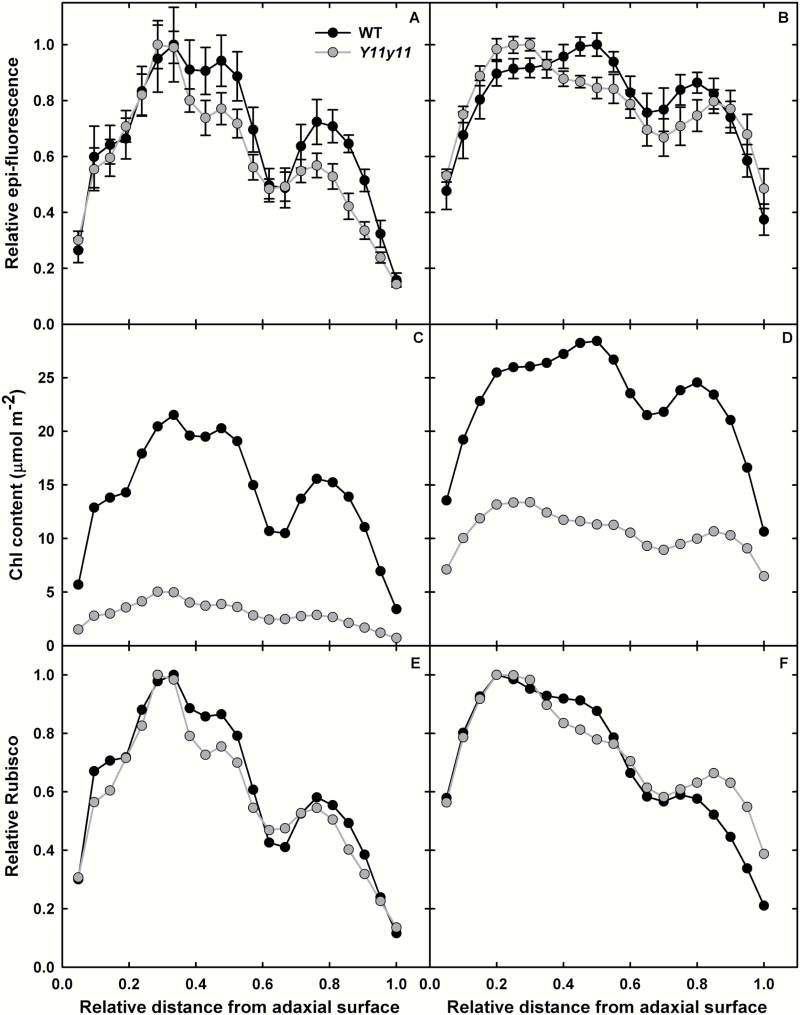
Epi-fluorescence, chl content, and relative Rubisco profiles in chamber-grown (A, C, E) and field-grown (B, D, F) WT (black) and Y11y11 (grey) leaves. Relative chl distribution from epi-fluorescence measurements (A, B) was converted to absolute chl content (C, D) based on total leaf chl content on an area basis. Relative Rubisco (E, F) was determined from previous relationships between Rubisco per chl versus cumulative chl (Evans, 1995, 1999). Sample size in (A, B) was n=6 except for chamber-grown Y11y11 (n=5). Error bars represent standard errors of the means.